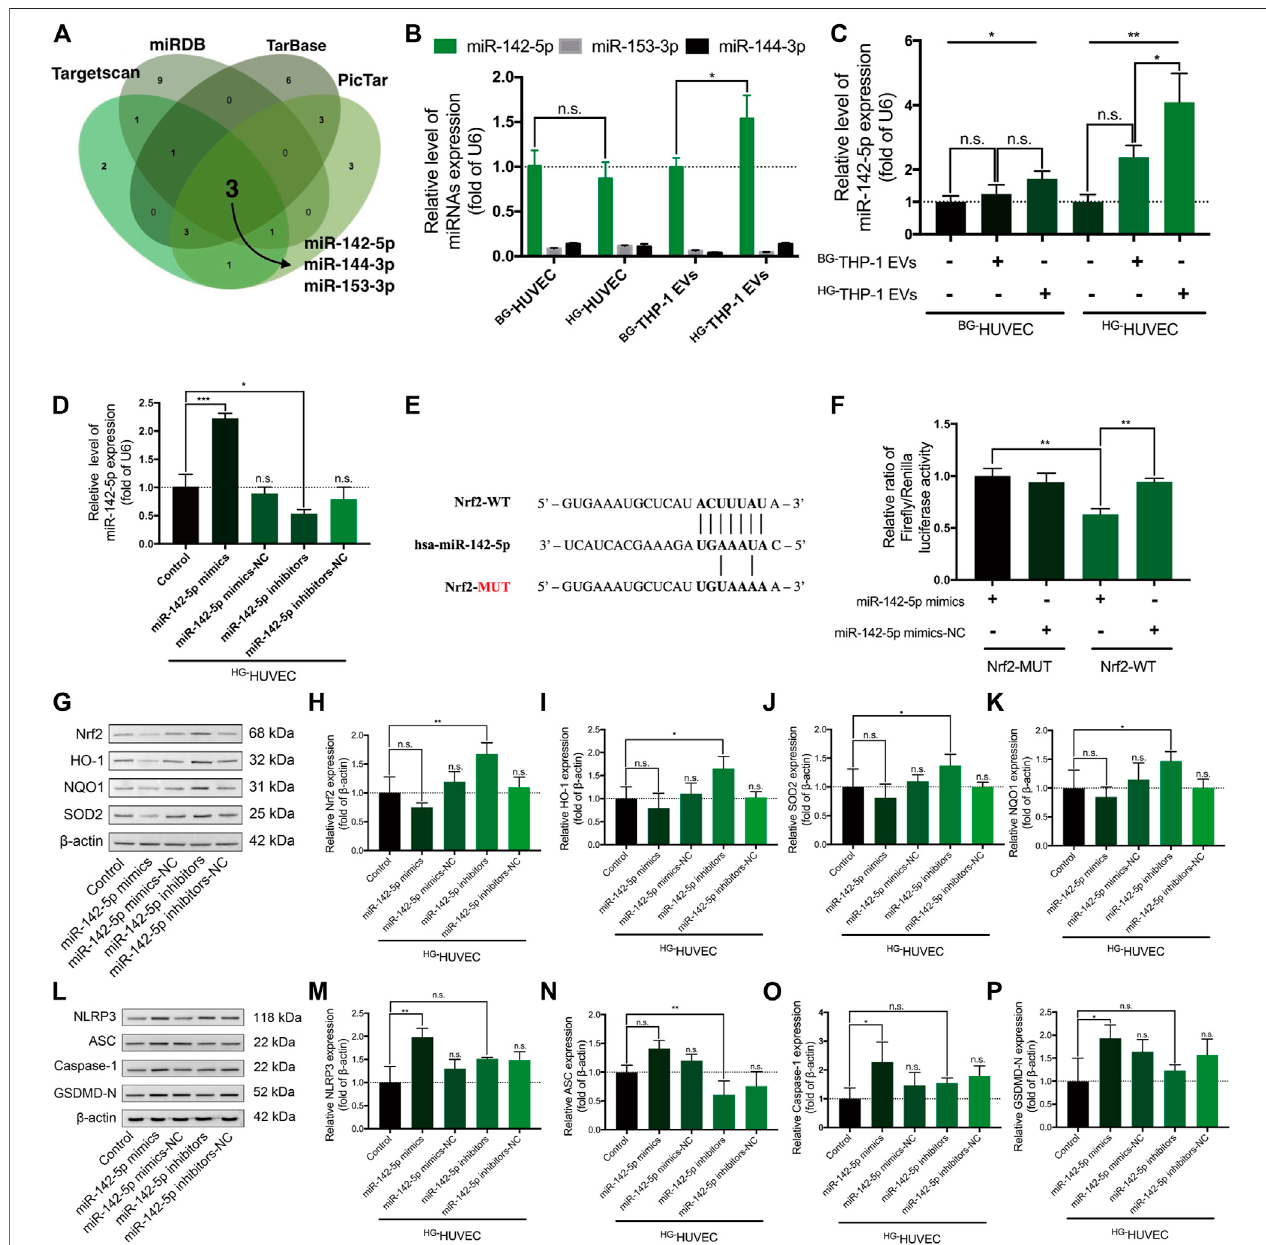
FIGURE 4 | Nrf2-targeting miR-142-5p regulates the Nrf2 and NLRP3 signaling pathway in HUVECs (A) Predicted Nrf2-targeting microRNAs from four miRNAs databases (B) Relative expression of miR-142-5p, miR-153-3p, and miR-144-3p in HUVECs and in THP-1 EVs by RT-qPCR (by t -test) (C) Relative expression of miR- 142-5pinHUVECstreatedwithTHP-1EVs (D) RelativeexpressionofmiR-142-5pinHUVECswithmiR-142-5pmimics/mimics-NC/inhibitors/inhibitors-NC transfection (E) ThebindingsequenceofmiR-142-5pinthe3 ʹ -UTRofNrf2transcript (F) Dual-luciferaseassayveri fi edthebindingrelationshipbetweenmiR-142-5pandthe3 ʹ - UTR of Nrf2 transcripts (G – K) MiR-142-5p regulating the expression of Nrf2, HO-1, SOD2, and NQO1 in HG- HUVECs (L – P) MiR-142-5p regulating the expression of NLRP3, Caspase-1, ASC, and GSDMD-N in HG- HUVECs. Data are presented as mean ± SD and analyzed using the ANOVA, n. s not signi fi cant, * p < 0.05, ** p < 0.01, *** p < 0.001. n =